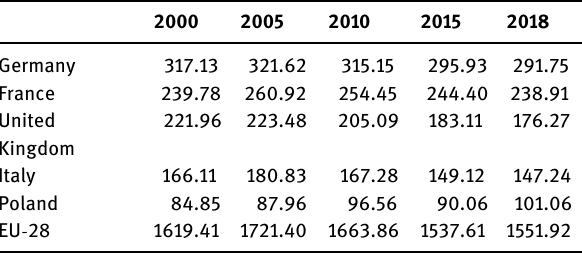
Table 1: Primary energy consumption in selected EU countries,